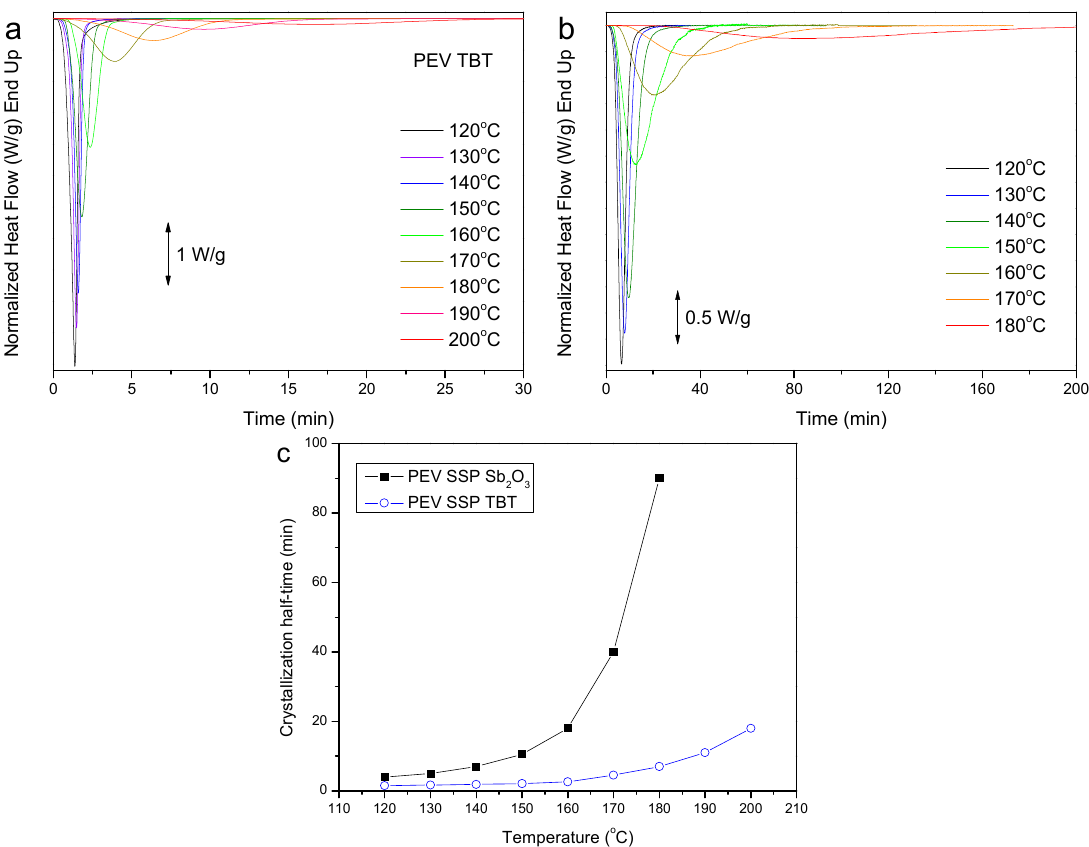
Figure 5. ( a ) and ( b ) isothermal crystallization peaks for the low and higher M w PEV samples, respectively, and ( c ) crystallization half-times vs temperature.